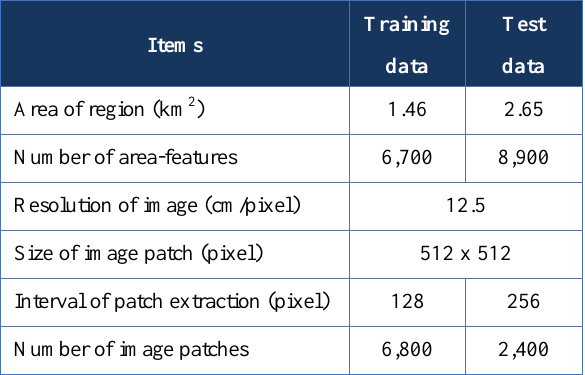
Table 1. Details of dataset